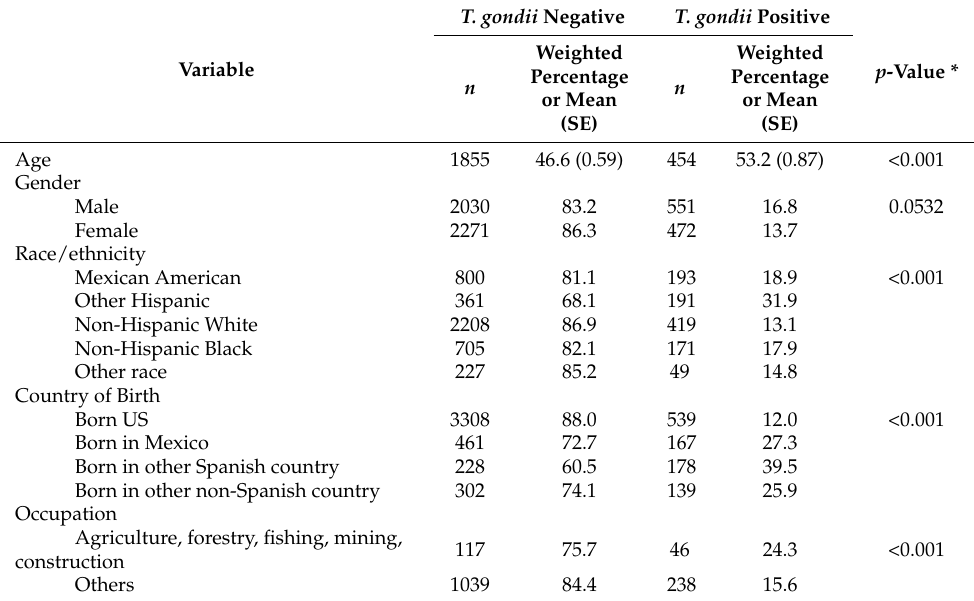
Table 3. Associations between T. gondii (positive/negative) and demographic variables.